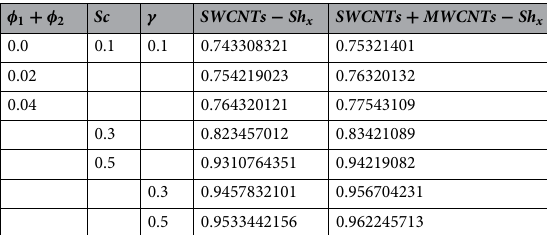
Table 3. Sherwood number versus the embedded